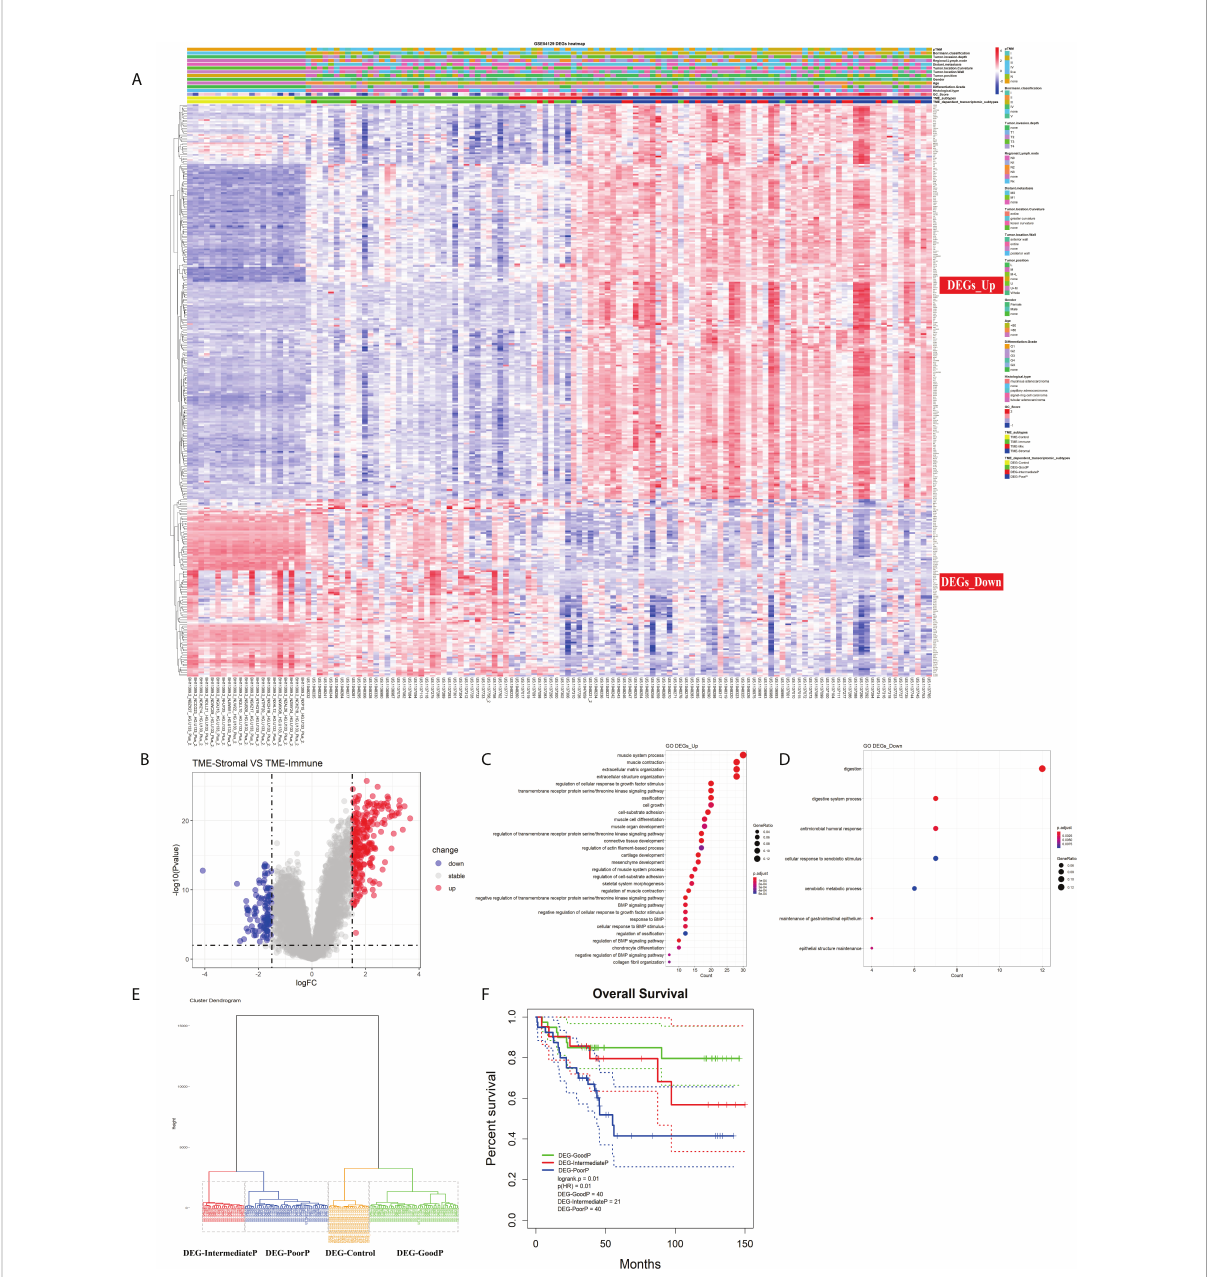
FIGURE 4 Investigation of the TME in fi ltration-dependent expression change. (A) Heatmap of the 345 differentially expressed genes (DEGs) between TME- Stromal and TME-Immune. (B) Volcano plot of the 345 DEGs. (C, D) GO enrichment analysis of the 345 DEGs: DEGs_Up and DEGs_Down. (E) Unsupervised hierarchical clustering of the 345 DEGs based on expression data to classify patients into four groups: DEG-Control, DEG-GoodP, DEG-IntermediateP, and DEG-PoorP. (F) Kaplan – Meier curves for overall survival (OS) of GC patients with the TME-dependent transcriptomic subtypes (log-rank